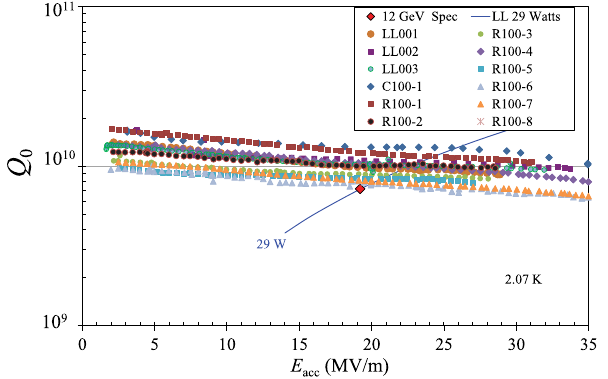
FIG. 28. Performance test of cavity C100-6 without helium